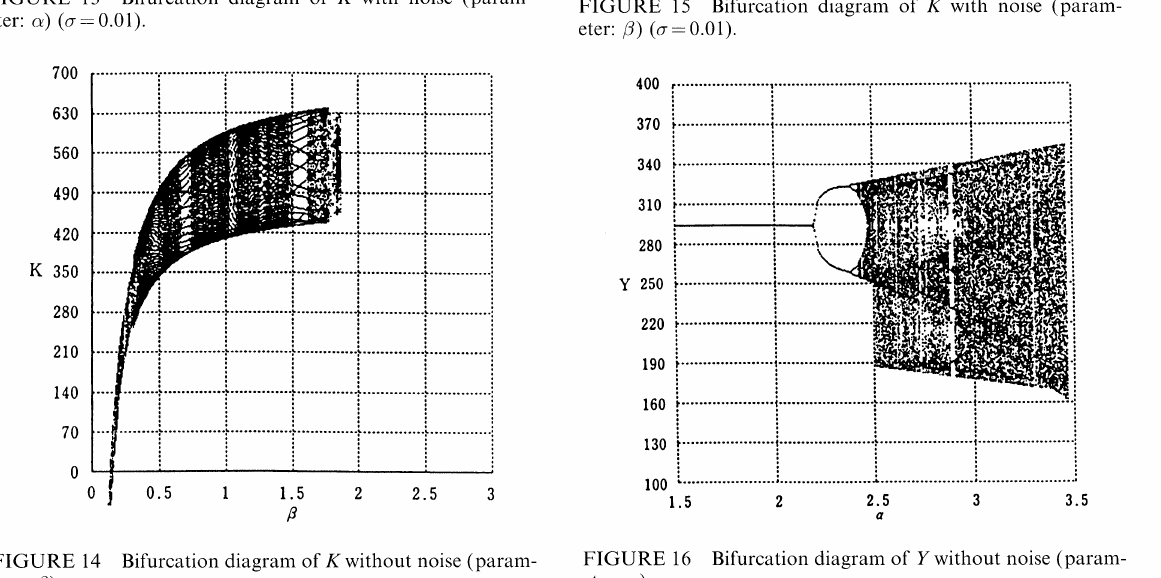
FIGURE 13 Bifurcation diagram of K with noise (param- eter: c) (c 0.01).